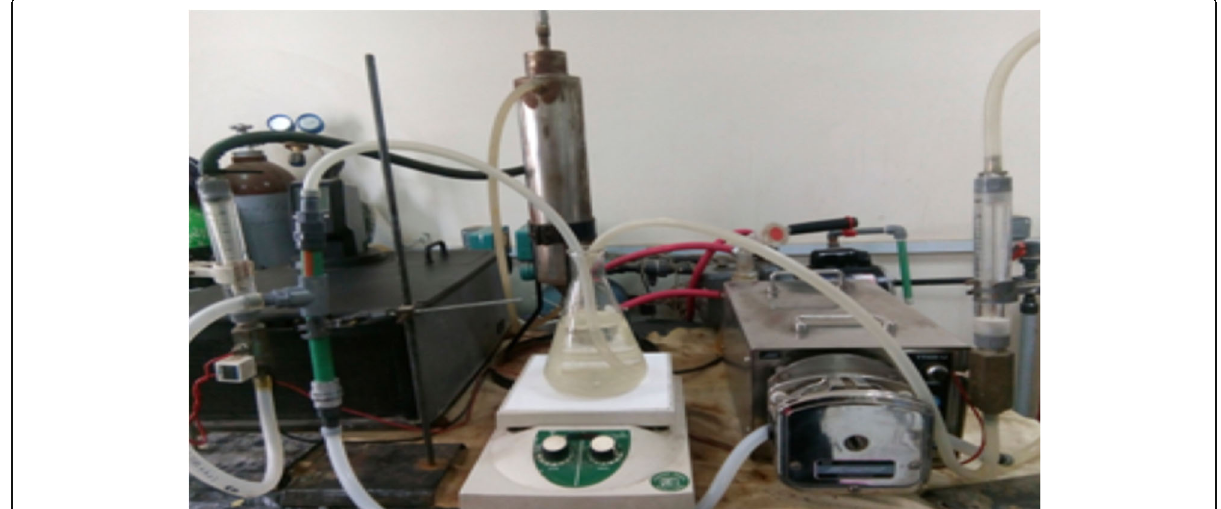
Fig. 19 VMD system used to assess the performance of the TBF